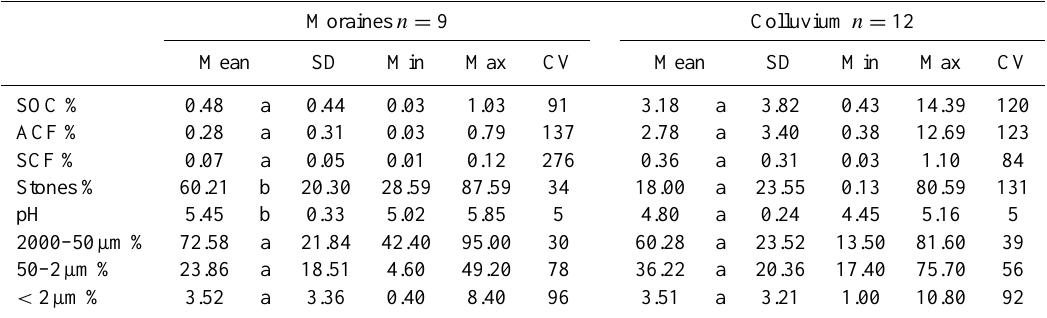
Table 2. Summary statistics of main properties in the soil samples on moraines and colluvium. Different letters indicate significant differences at the p level 0.05 between moraines and colluvium